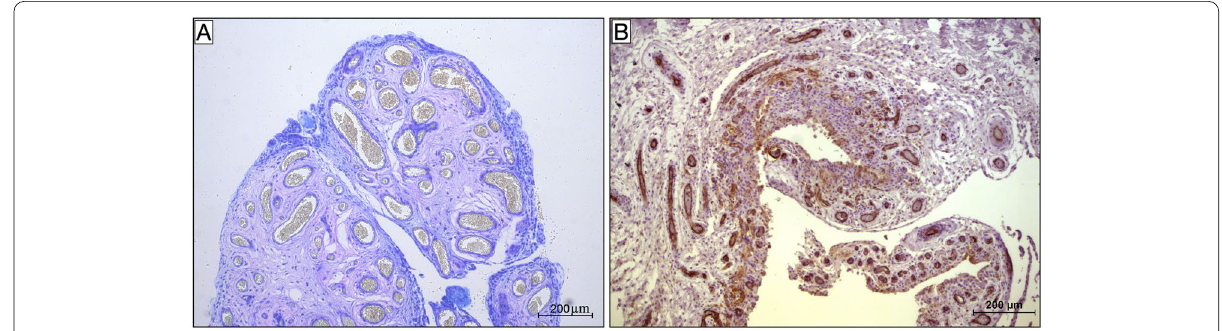
Fig. 4 A, B . Synovial hypervascularity. A . Toluidine blue staining; B. Paraffin sections stained for CD31. Both images, 10